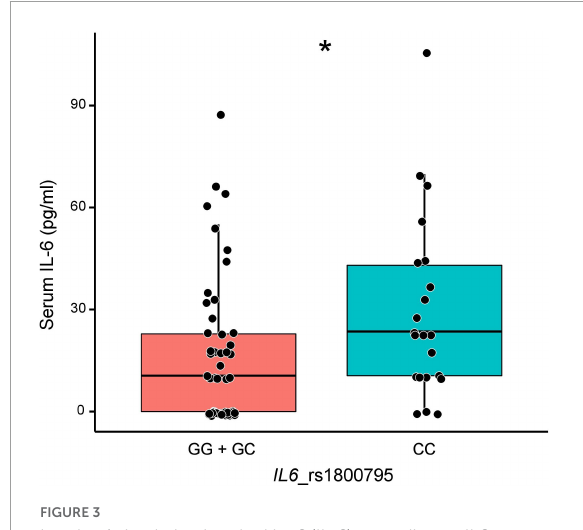
FIGURE3 Levels of circulating interleukin-6 (IL-6) according to IL6 rs1800795 genotypes. * P =